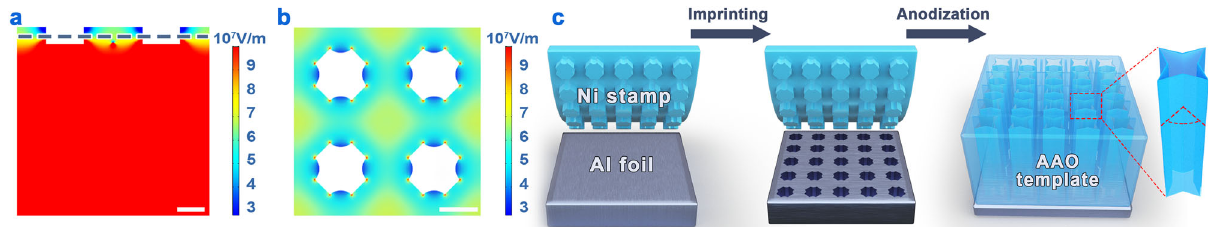
Fig. 1 Fabrication of templates with in-plane shape-designable pores. COMSOL-simulated electric fi elds at a vertical cross-section and b near-surface lateral cross-section of an aluminum foil patterned with four-leaf clover-like nanoconcaves of 400-nm spacing and tetragonal arrangement under an anodization voltage (AV) of 120 V, the dashed line in a at the half-depth of nanoconcaves marks the near-surface lateral cross-section in b . c Schematic illustration for the fabrication process of AAO template (from left to right): fabricating Ni imprint stamp and electro-polishing aluminum foil; transferring the structural feature of Ni stamp by imprinting to equip aluminum surface with an array of four-leaf clover-like nanoconcaves; anodizing the imprinted area at different AVs. Scale bars: